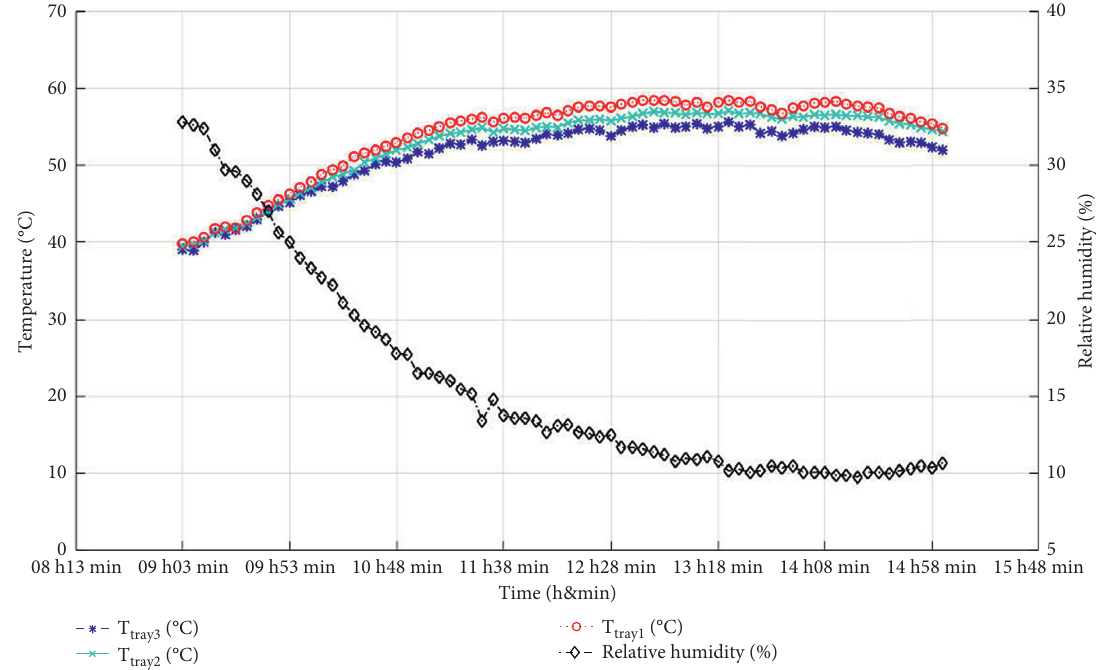
Figure 13: Temperature and irradiance profiles with regulation in the mixed